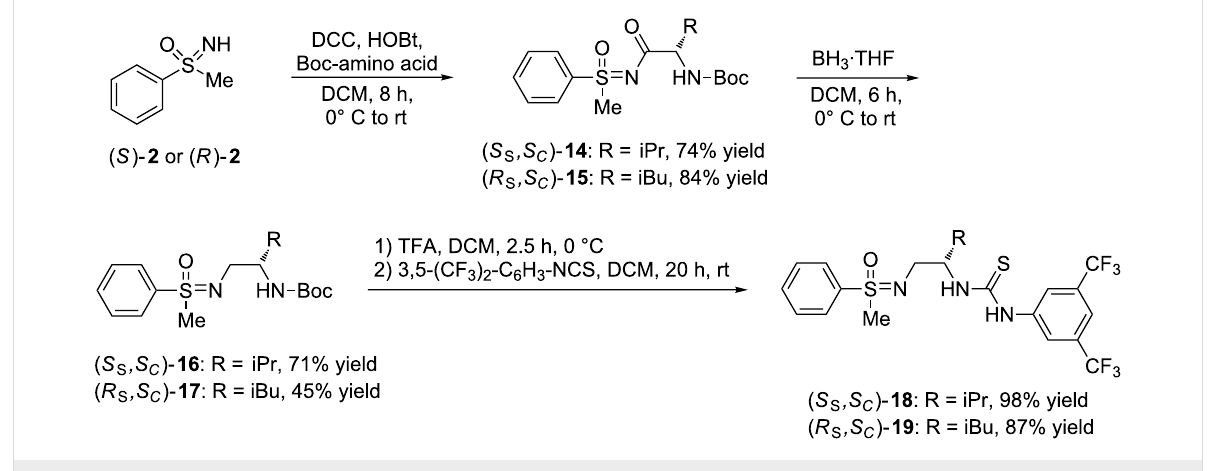
Scheme 5: Syntheses of ethylene-linked sulfonimidoyl-containing thioureas ( S S , S C )- 18 and ( R S , S C )- 19 .